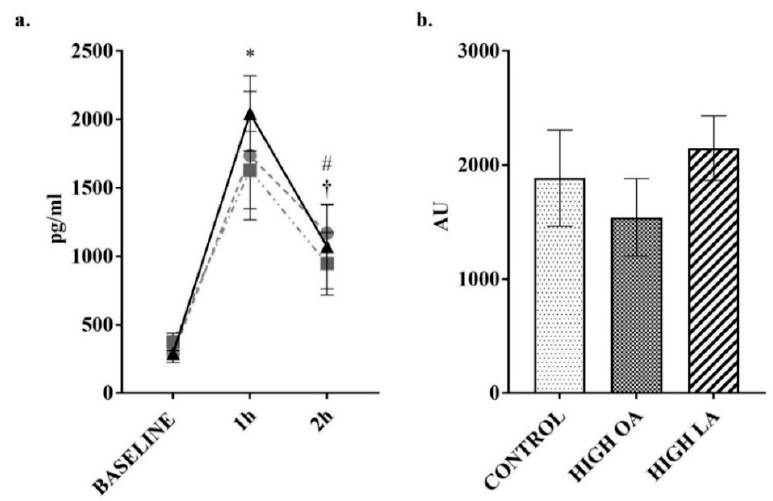
Figure 5. Change in insulin over 2 h postprandial period. ( a ) plotted values. = control meal, (cid:4) = high-OA, (cid:78) = high-LA; ( b ) Net area under curve (AUC) from baseline. Measured in plasma using a multiplex immunoassay. All data displayed as mean ± SEM, all data points n = 8. * = significantly different ( p < 0.05) to baseline for all test meals. # = significantly different ( p < 0.05) to baseline for control meal. † = significantly different ( p < 0.05) to 1 h for the high-LA test meal.